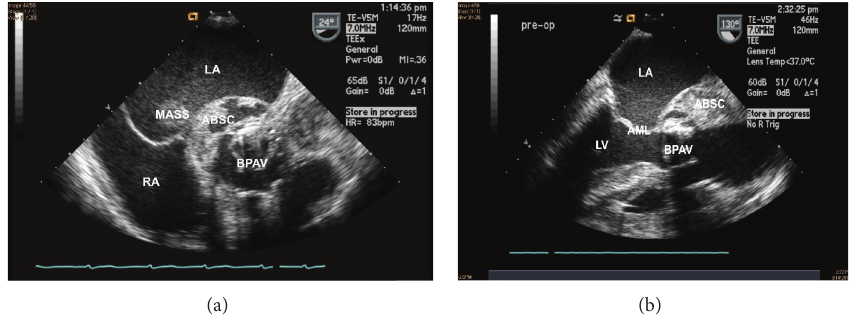
Figure 1: Transesophageal echocardiogram in short axis (a) and long axis (b) views, showing an extensive aortic root abscess around a bioprosthetic aortic valve, forming a fistulous communication to left atrium (legend: ABSC = abscess, LA = left atrium, MASS = mass in LA, BPAV = bioprosthetic aortic valve, RA = right atrium, AML = anterior mitral leaflet, and LV = left ventricle).